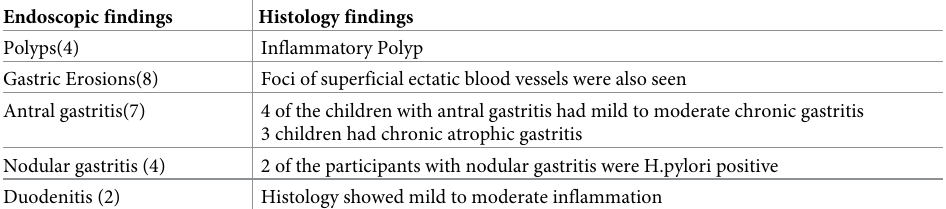
Table 3. Histopathology findings in the study participants.